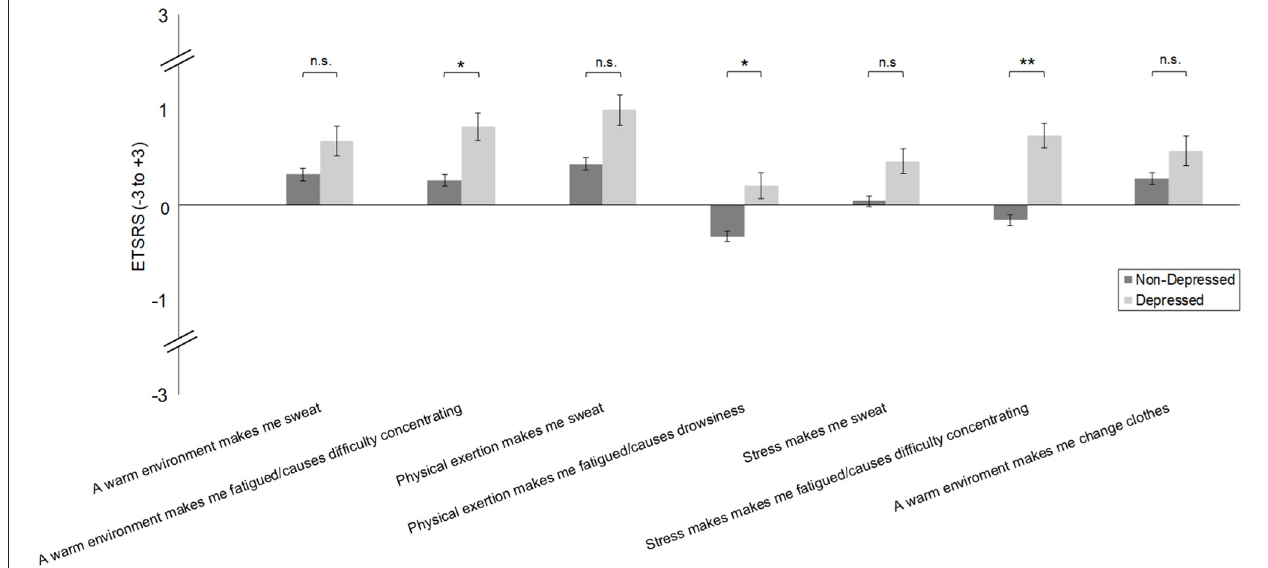
FIGURE 2 | Autonomic and behavioural thermoregulation [Experienced Temperature Sensation and Regulation Survey (ETSRS)] in depressed vs. non-depressed individuals [Patient Health Questionnaire (PHQ)]. Bars represent mean values and error bars display the standard error of the means. * p < 0.05. ** p < 0.01. n.s. = not